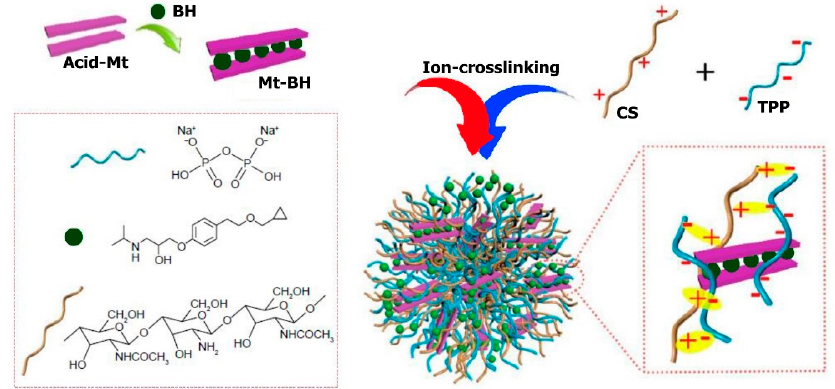
Figure 7. Schematic representation of the BH-Mt / CS nanoparticles preparation process. Reproduced from [71] with permission from Dovepress.